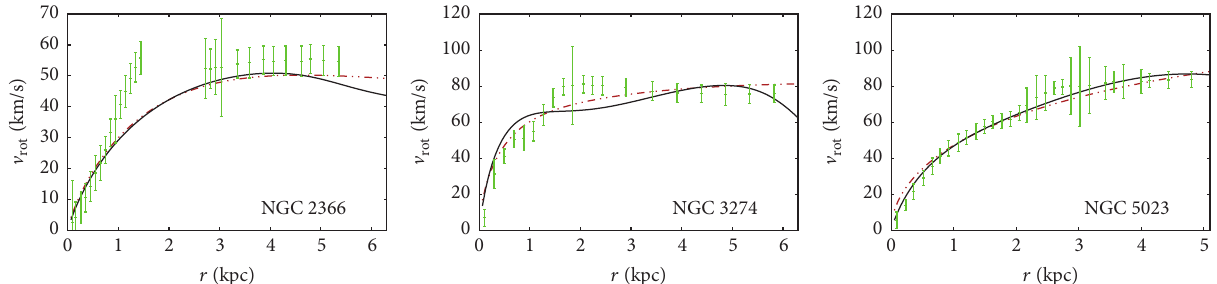
Figure 4: Best fit curves for the LSB II. galaxy sample. The solid black lines refer to the baryonic matter + BEC model, while the dashed red lines to the baryonic matter + NFW model. As for HSB galaxies, the BEC model fails to explain the extended flat regions of the rotation